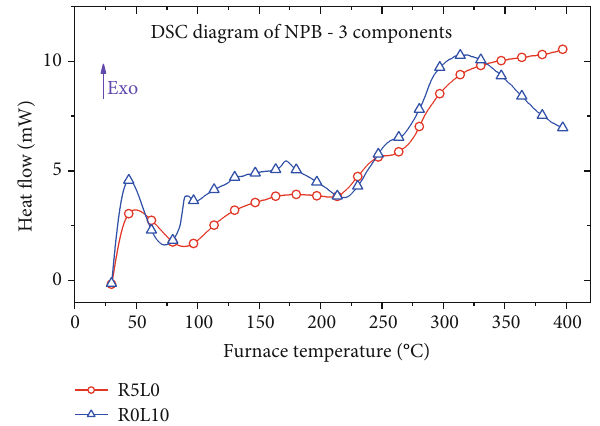
Figure 7: DSC diagrams of NPB of R5L0 and R0L10